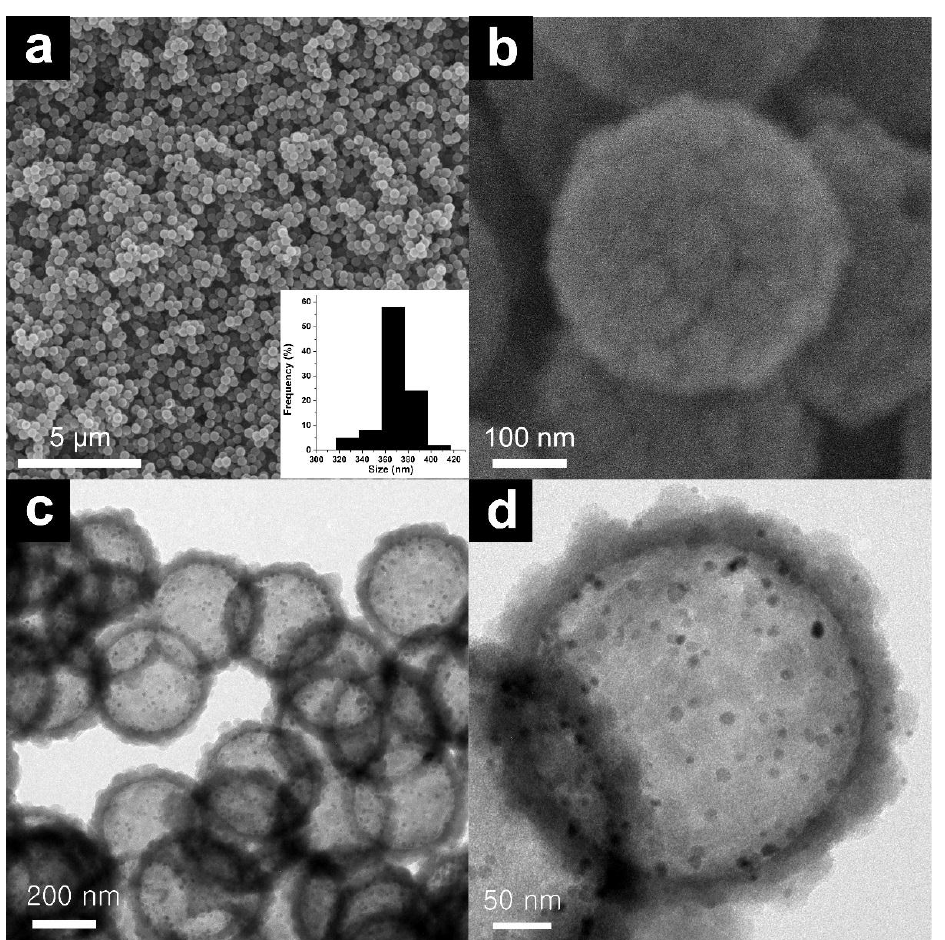
Figure 5. SEM images ( a , b ) and TEM image ( c , d ) of PdO/ZnO@mSiO 2 hybrid nanocatalyst. The insert in ( a ) is the size distribution of PdO/ZnO@mSiO 2 hybrid nanocatalyst.